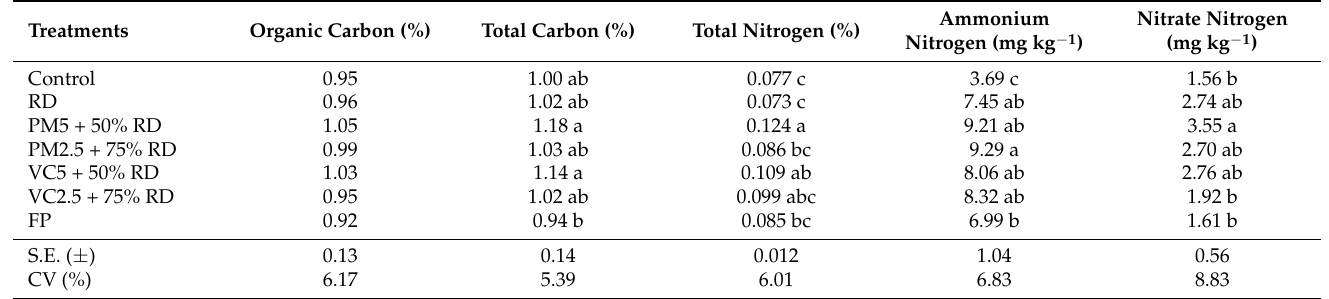
Table 3. Carbon and nitrogen status after rice harvest under different treatments of organic manures and inorganic fertilizers.